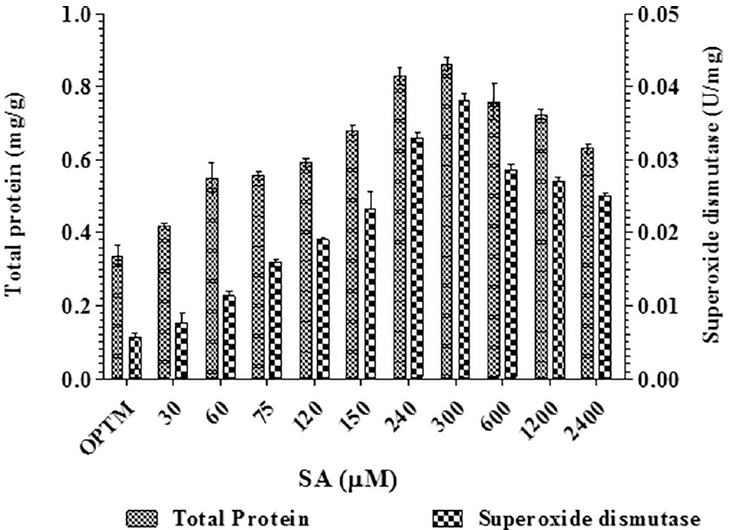
Fig 3. Effect of different concentrations of SA on total protein and superoxide dismutase activity by P . microspora